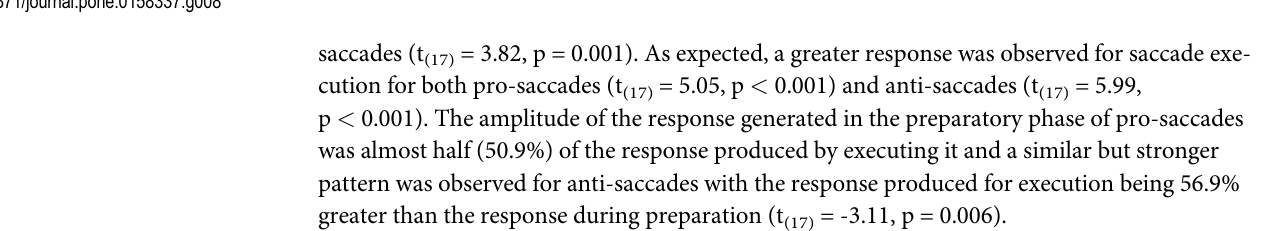
Fig 8. BOLD responses averaged across 18 hemispheres from 9 subjects for ipsilateral and contralateral execution of pro-saccades and anti- saccades, in the SC. Key as for Fig 3.